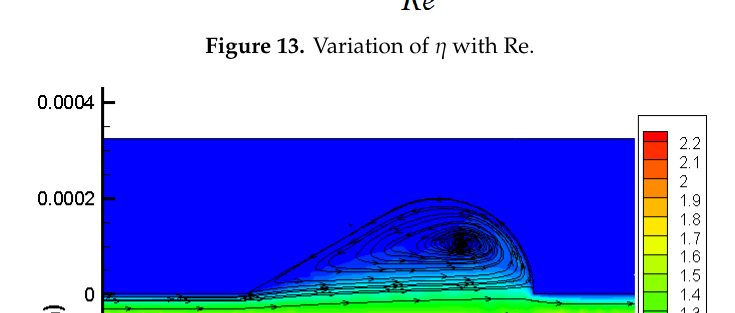
Figure 13. Variation of ƞ with Re.